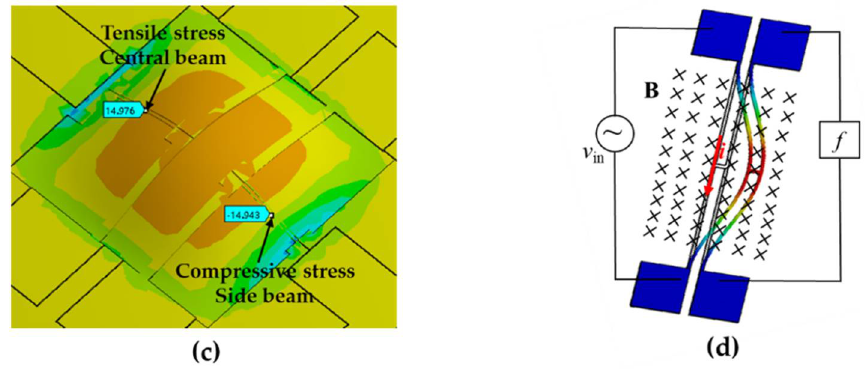
Figure 1. ( a ) Schematic of the resonant pressure sensor, including an silicon-on-insulator (SOI) wafer and an silicon-on-glass (SOG) cap. In the SOI wafer, there is a square pressure sensitive diaphragm in the handle layer, two H-shaped doubly-clamped resonators in the device layer. The SOG cap with a cavity, sputtered with the getter material, is used to form a vacuum packaging for the resonators and reduce the temperature sensitivity of the resonant pressure sensor; ( b ) Zoom in for the key portion of Figure 1a; ( c ) Pressure under measurements causes the deformation of the pressure-sensitive diaphragm, leading to frequency shift of the resonators; ( d ) Electromagnetic excitation / electromagnetic detection, the resonator experiences a Lorentz force to excite the beam into vibration, and the resulting vibrations are sensed by detecting the magnetically induced voltage, developed across the beam.